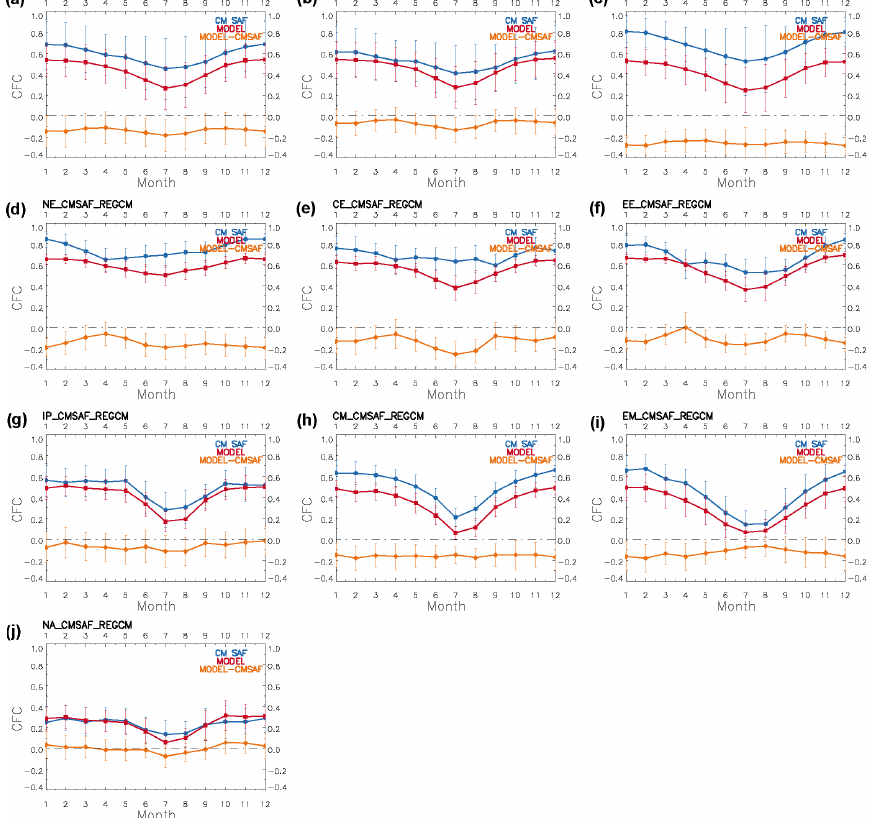
Figure 7. The same as Fig. 1 but for RegCM4 and CM SAF COT.